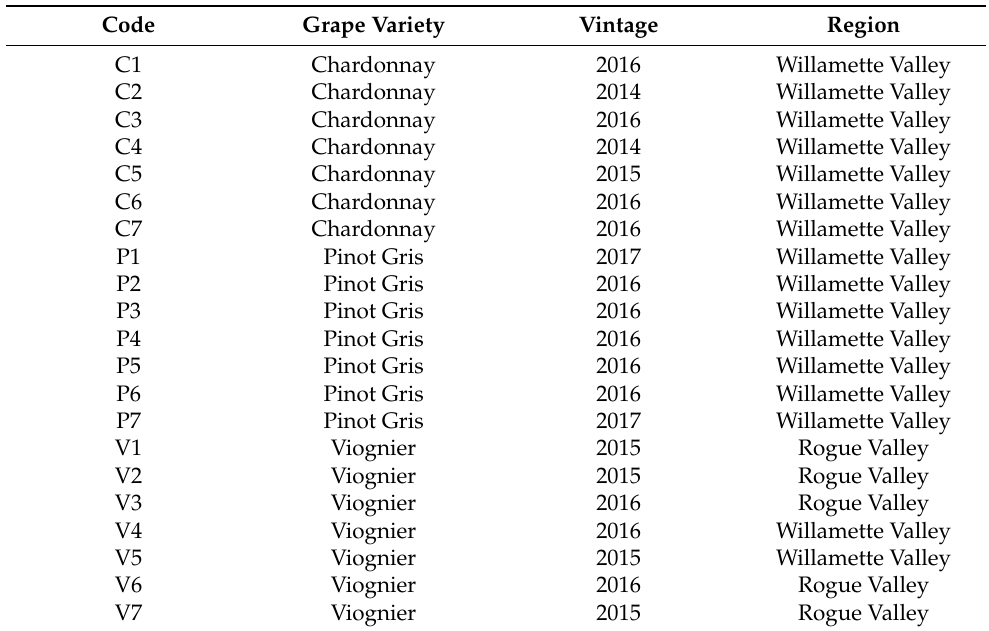
Table 1. Wines selected for this